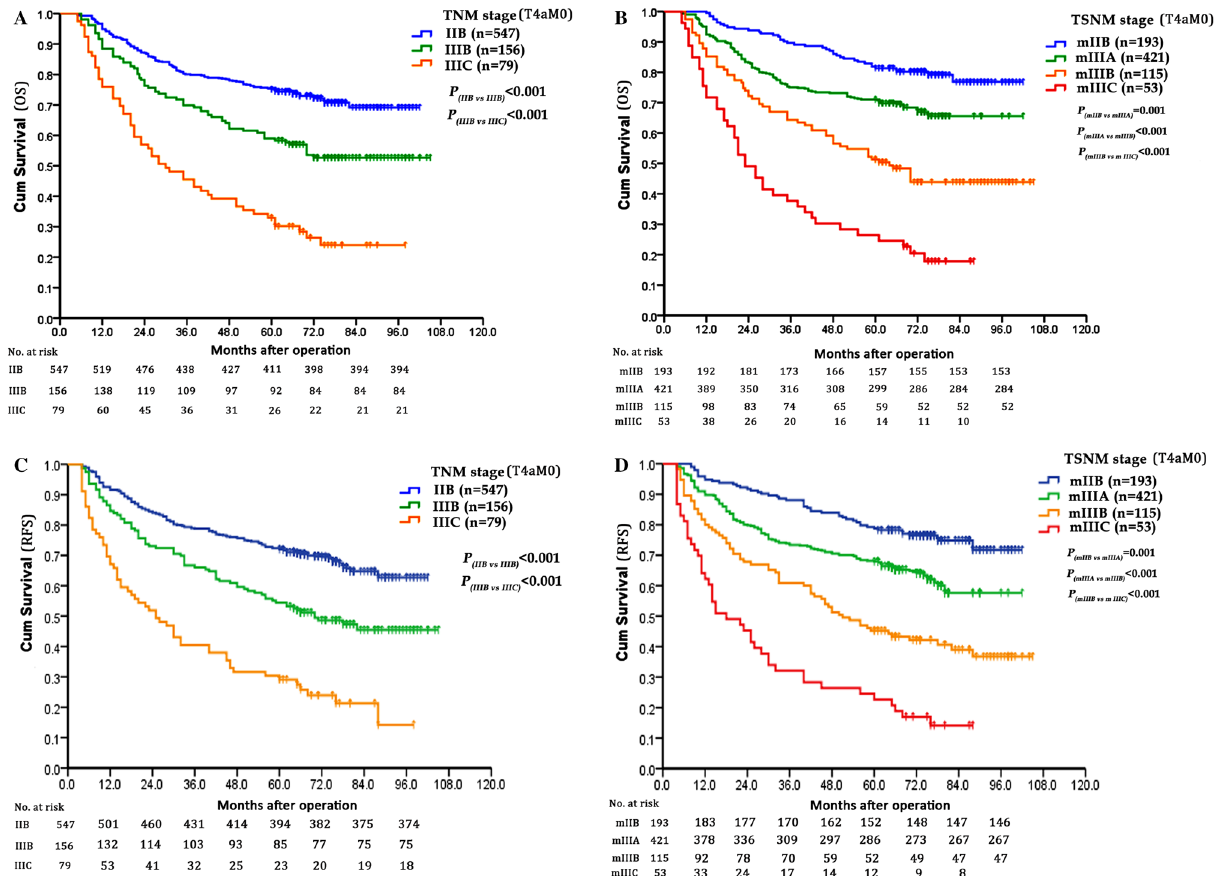
Figure 6. Survival curves of patients according to different tumor stages. ( A ) OS curves of TNM stage ( P < 0.001). ( B ) OS curves of mTSNM stage ( P < 0.001). ( C ) RFS curves of TNM stage ( P < 0.001). ( D ) RFS curves of mTSNM stage ( P <